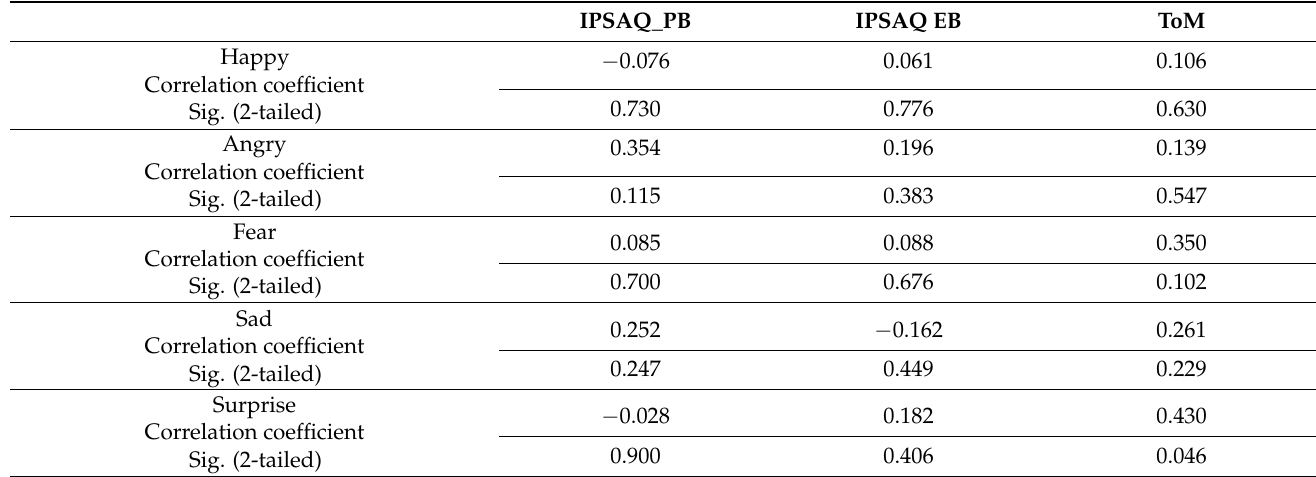
Table 1. Spearman correlations among IPSAQ, ToM, and facial